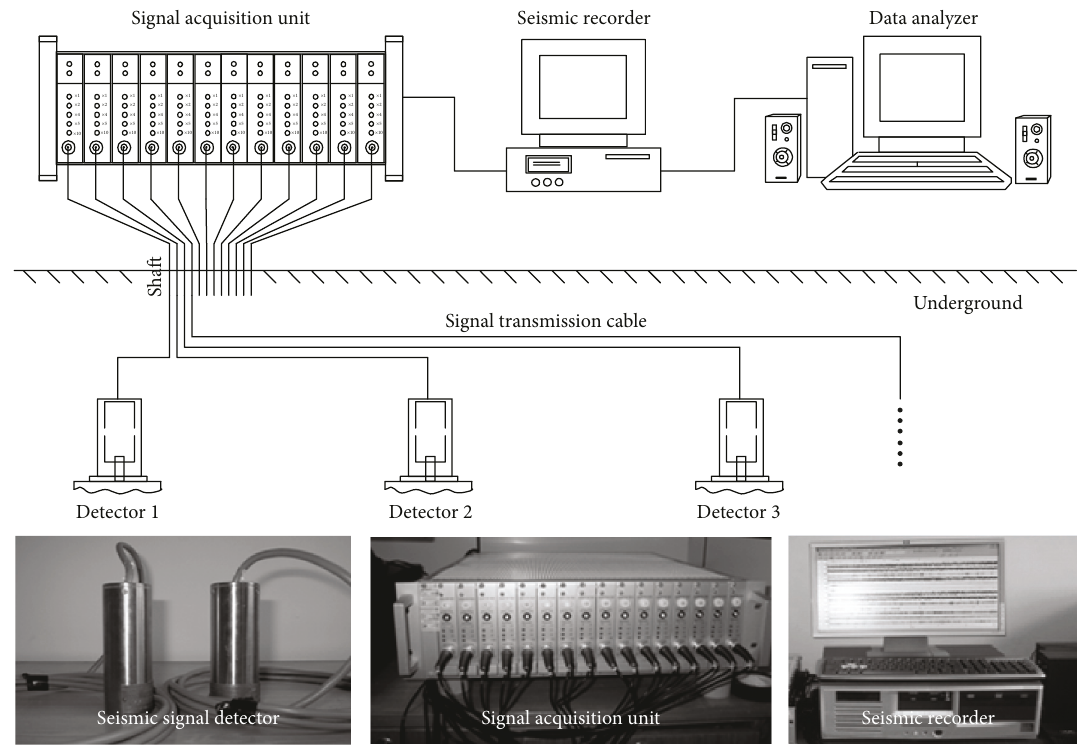
Figure 3: Organizational structure and key components of the applied microseismic monitoring